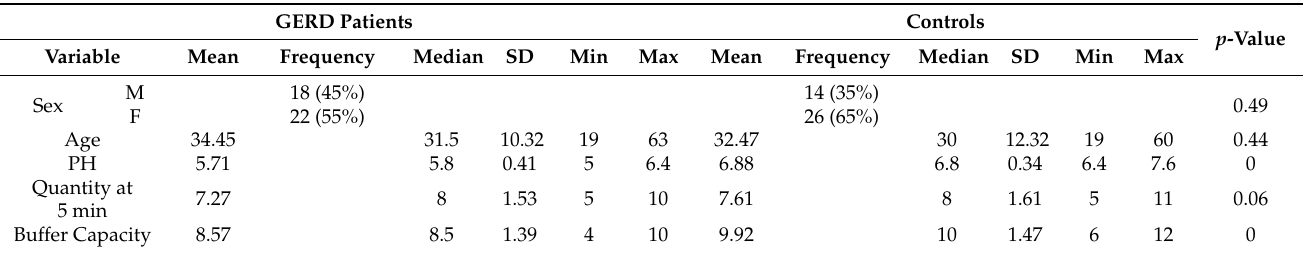
Table 3. Statistical results referring to the saliva quantity at 5 min, salivary pH, and buffering capacity in the two studied